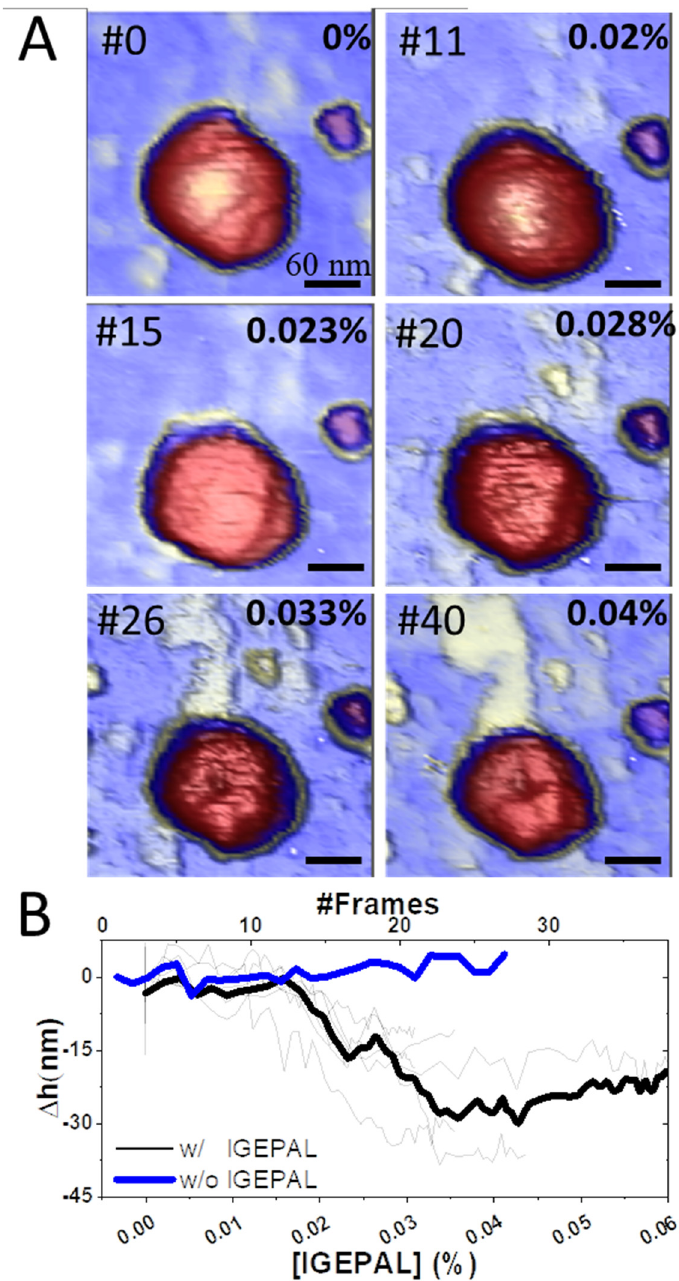
Figure 4. Effect of IGEPAL gradient on TGEV virions ( A ). Topographical images were taken while the amount IGEPAL was increased (video S4). The frame number is shown in the upper left corner and the concentration of IGEPAL in the right ( B ). Height loss during the time course assay. Experimental curves are shown in grey and the average curve of 8 observations is shown in black. As a control, the height of 3 particles (video S5) was tracked in buffer without detergent (blue).